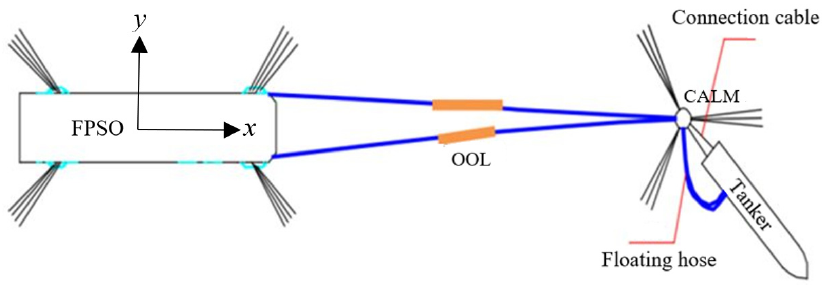
Figure 2. Top view of the FPSO CALM buoy offloading system.